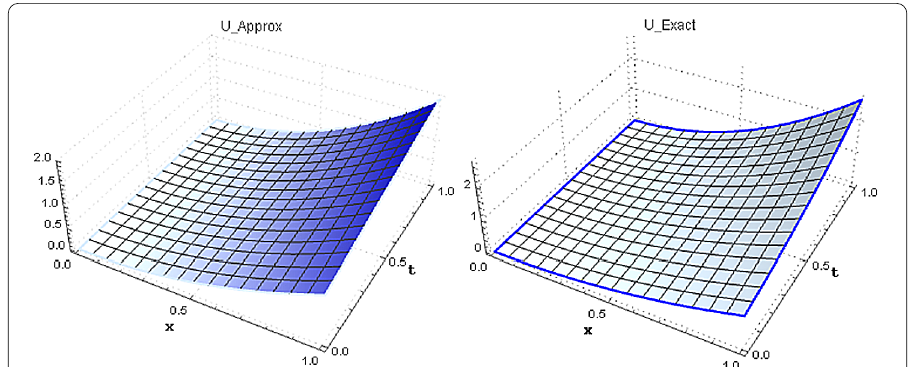
Figure 1 Comparison of the third-order approximate solution (4.7) with exact solution for α = 1